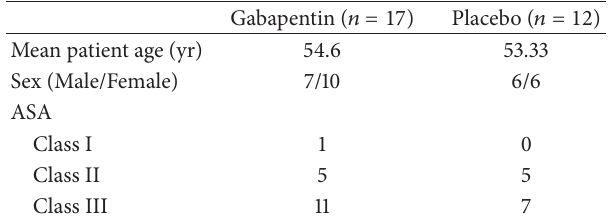
Table 1: Demographics of patients in the control (placebo) versus study group